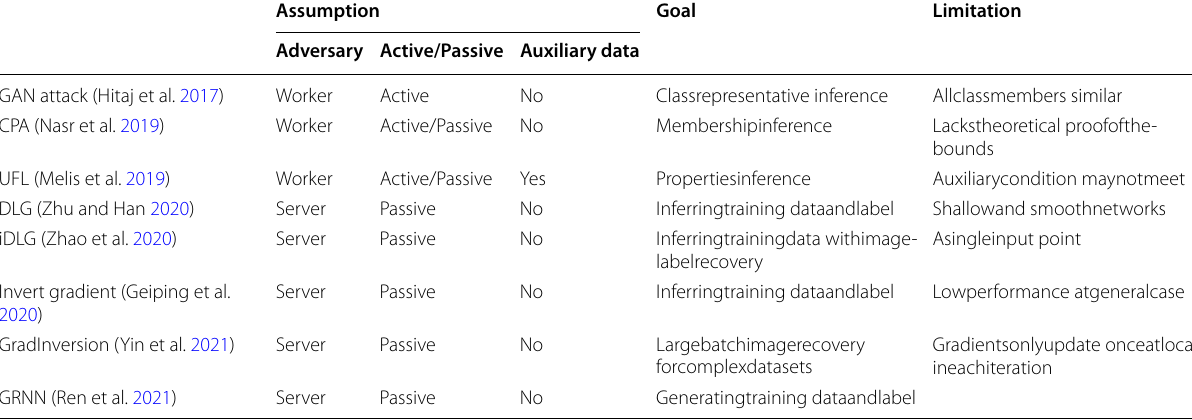
Table 2 Privacy inference attacks against FL in the training